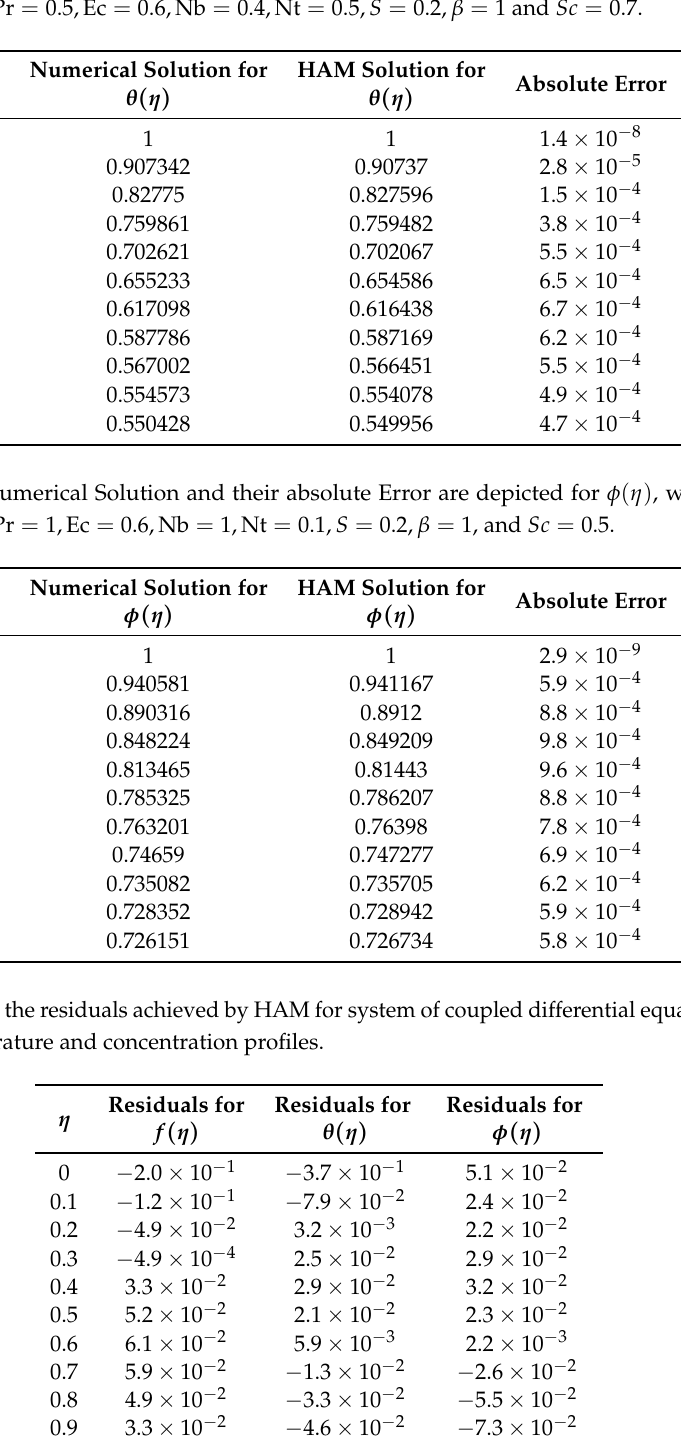
Table 3. HAM, Numerical Solution and their absolute Error are elobarated for θ ( η ) , when h = − 0.5, λ = 0.2,kr = 0.2,Pr = 0.5,Ec = 0.6,Nb = 0.4,Nt = 0.5, S = 0.2, β = 1 and Sc = 0.7.